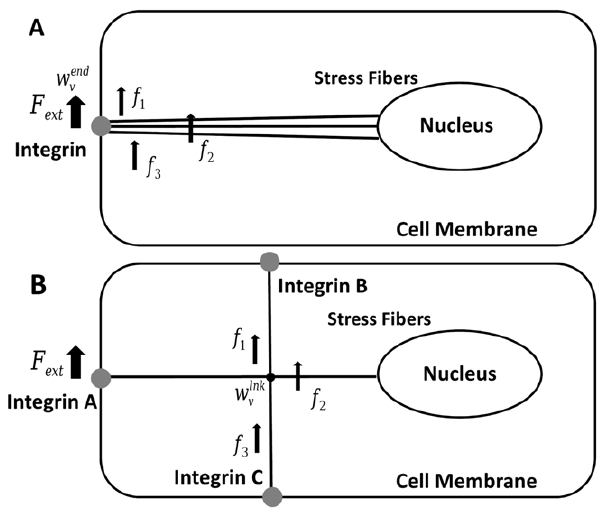
Figure 10. Examples of simple stress fiber network topologies. ( A ) Three stress fibers aligned nearly parallel to one another and linked together at their ends, and ( B ) two stress fibers aligned perpendicular to one another with one of them constrained to move only in the axial direction.